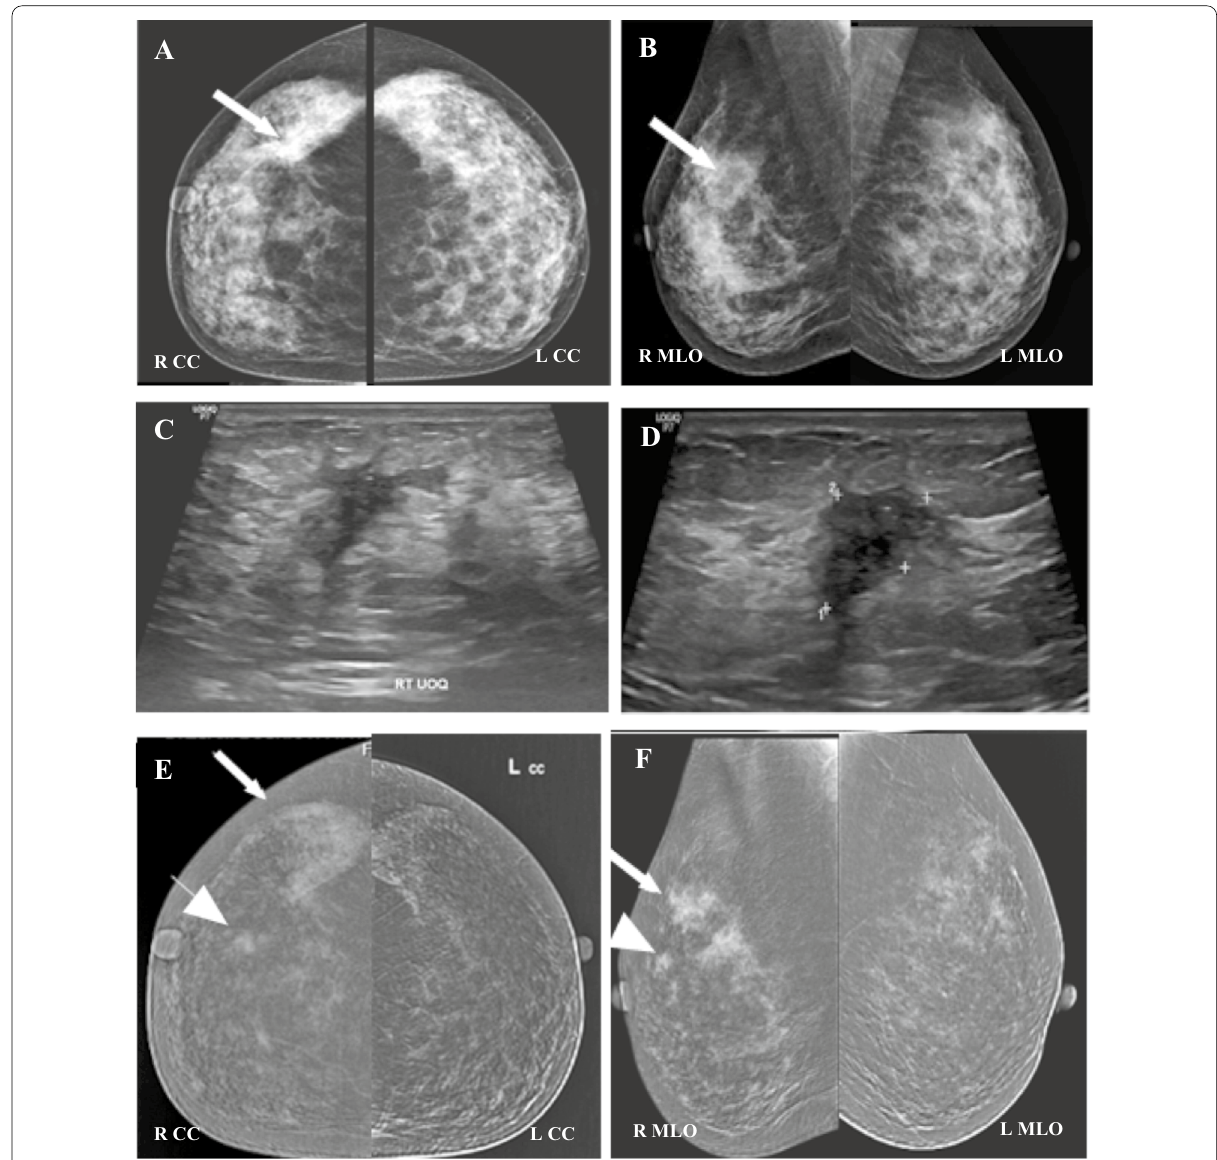
Fig. 4 A 29-year-old female, complaining of palpable right breast swelling and induration. (A) Craniocaudal mammographic view of both breasts, and B Mediolateral mammographic views of both breasts revealed right upper outer quadrant breast focal asymmetry (arrows). (C& D) Ultrasound images showing right upper outer quadrant irregular hypoechoic two soft tissue masses with spiculated margin, posterior attenuation, and vertical orientation. (E) Craniocaudal CEM view of both breasts, and (F) Mediolateral CEM views of both breasts revealed right upper outer quadrant heterogenous focal (arrow heads) and segmental (arrows) non-mass enhancement. Pathology revealed invasive ductal carcinoma. CEM confirmed the malignant nature of right breast lesion and proved lesion multiplicity (two malignant